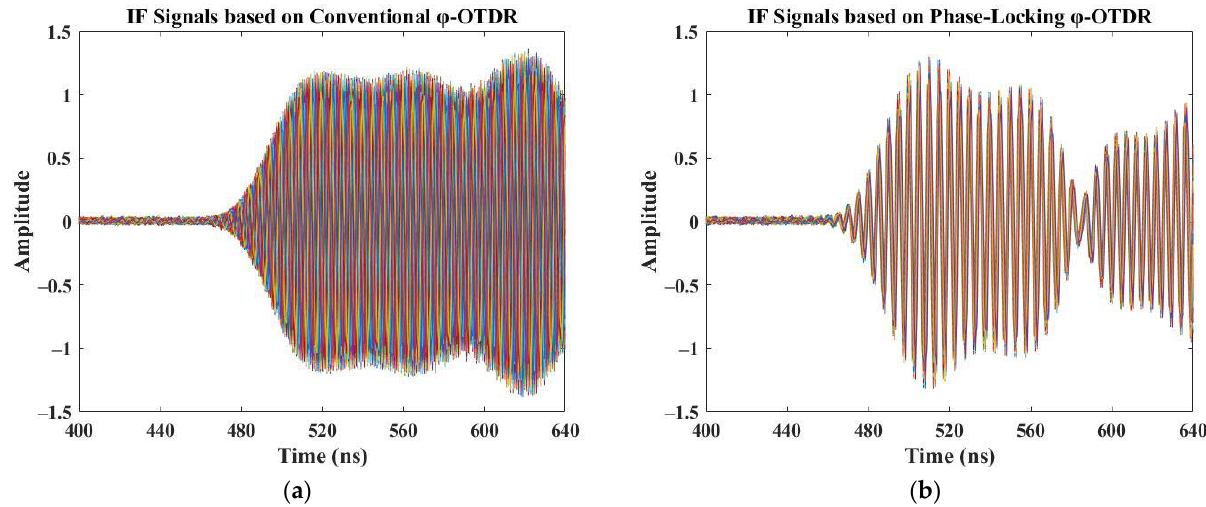
Figure 6. Intermediate frequency (IF) signals based on conventional ( a ) and phase-locking ( b ) are collected continuously for 200 periods.